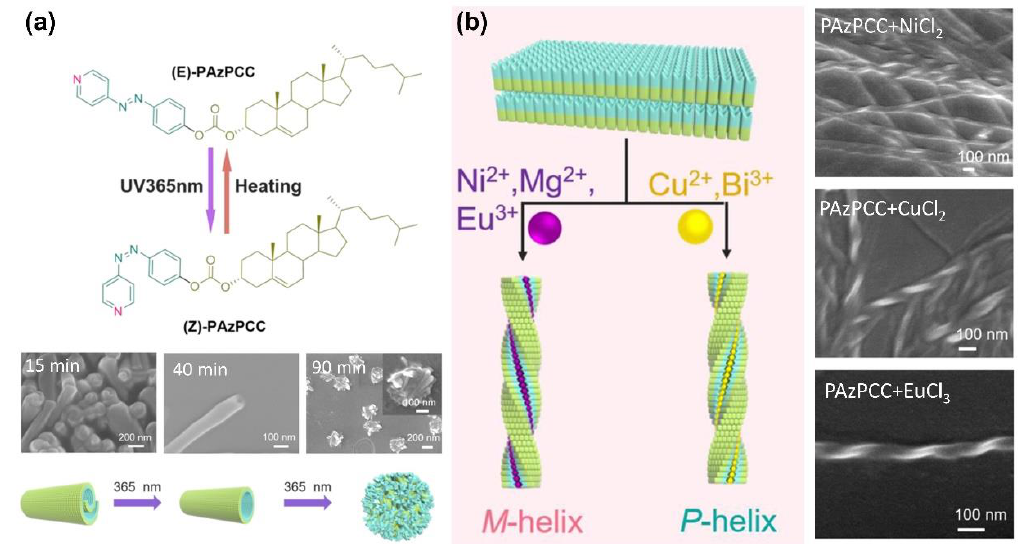
20 of 29 Figure 19. Complexation via axial coordination between PAzPy and ZnTPP or CoTPP. Reprinted with permission from [106]. Copyright 2006, Wiley. In addition, Zhao and colleagues fabricated cholesterol-AzPy conjugate organogels